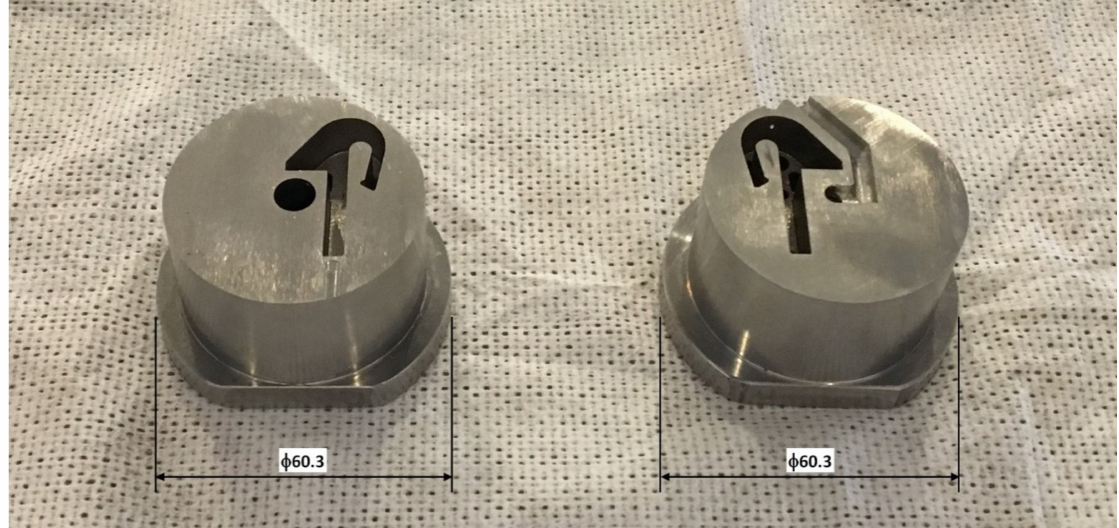
Figure 29. The core/inserts for injection molding optimized by simulations (Figure 28) 3D-printed (L-PBF) in AM Corrax [62]. The displayed dimensions are in